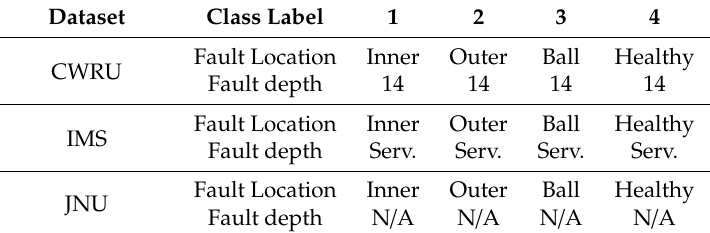
Table 2. Details of the dataset used in this experiment.